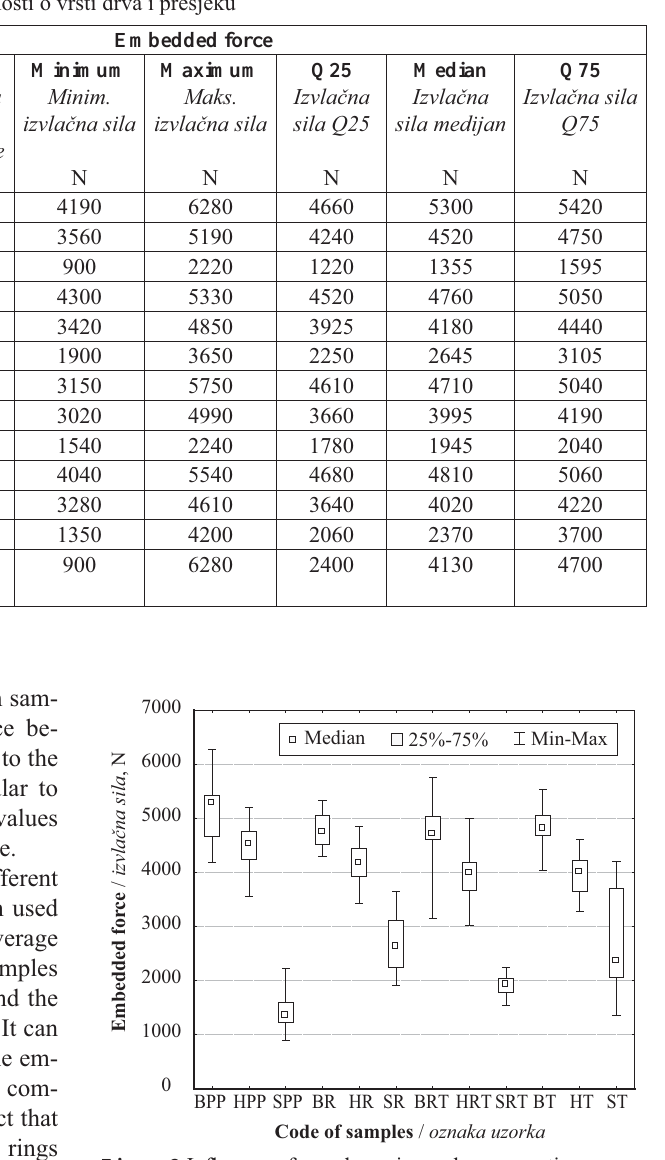
Table 2 Descriptive statistics for embedded force depending on wood species and cross-section